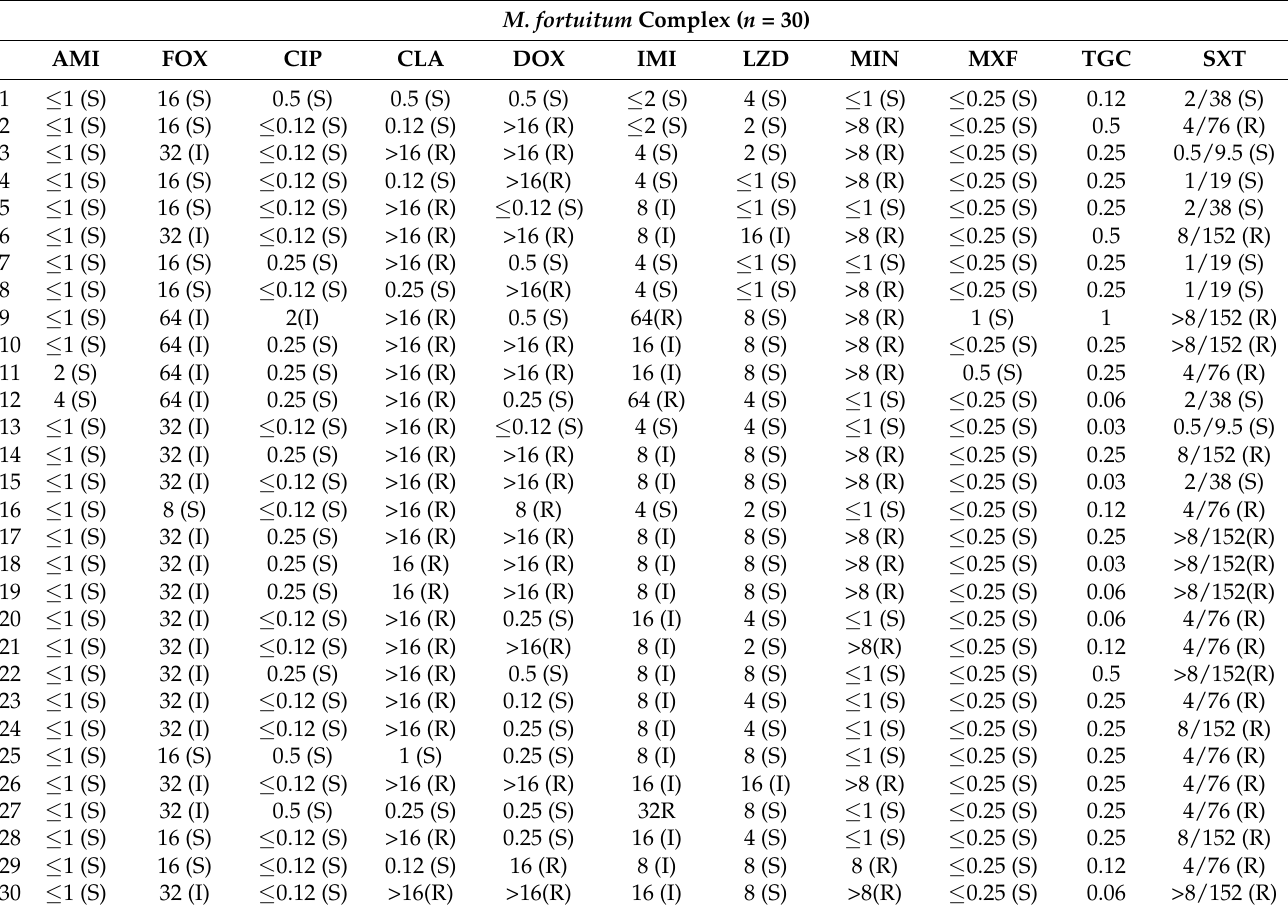
Table 9. Results of in vitro susceptibility testing for M. fortuitum complex